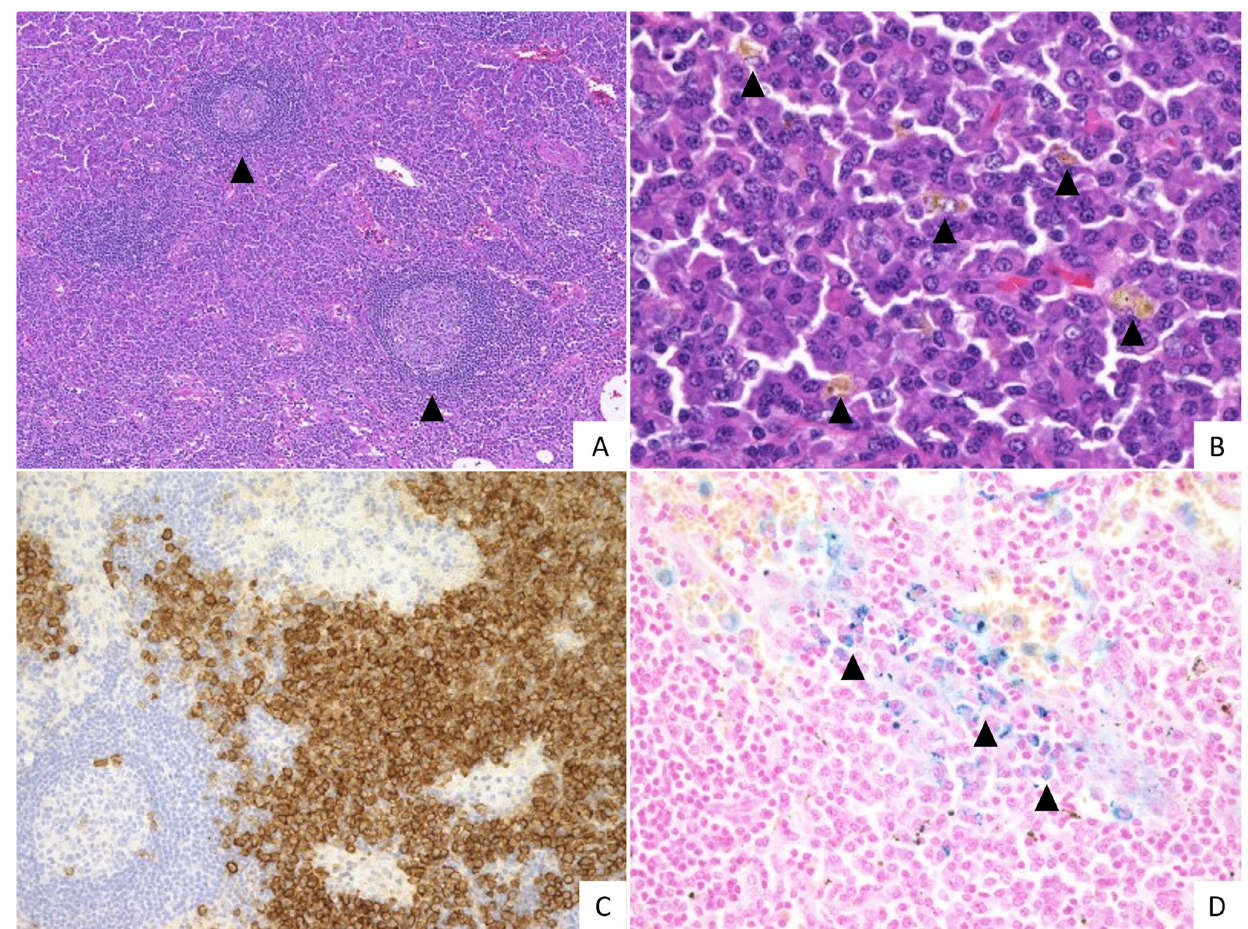
Figure 1. Histopathological features of the IPL group. ( A ) Interfollicular areas are expanded and germinal centers (GCs) appear hyperplastic (arrowheads) (H&E, 10×). ( B ) The sheet-like proliferation of mature plasma cells in the interfollicular areas and hemosiderin deposition are observed (arrow heads) (H&E,40×). ( C ) Numerous plasma cells are observed in the interfollicular areas (CD138, 20×). ( D ) Hemosiderin deposition is observed (arrowheads) (Berlin blue staining, 40×). This case was scored: vascularity grade 0, plasmacytosis grade 3, regressed GC grade 2, and hyperplastic GC grade 2.